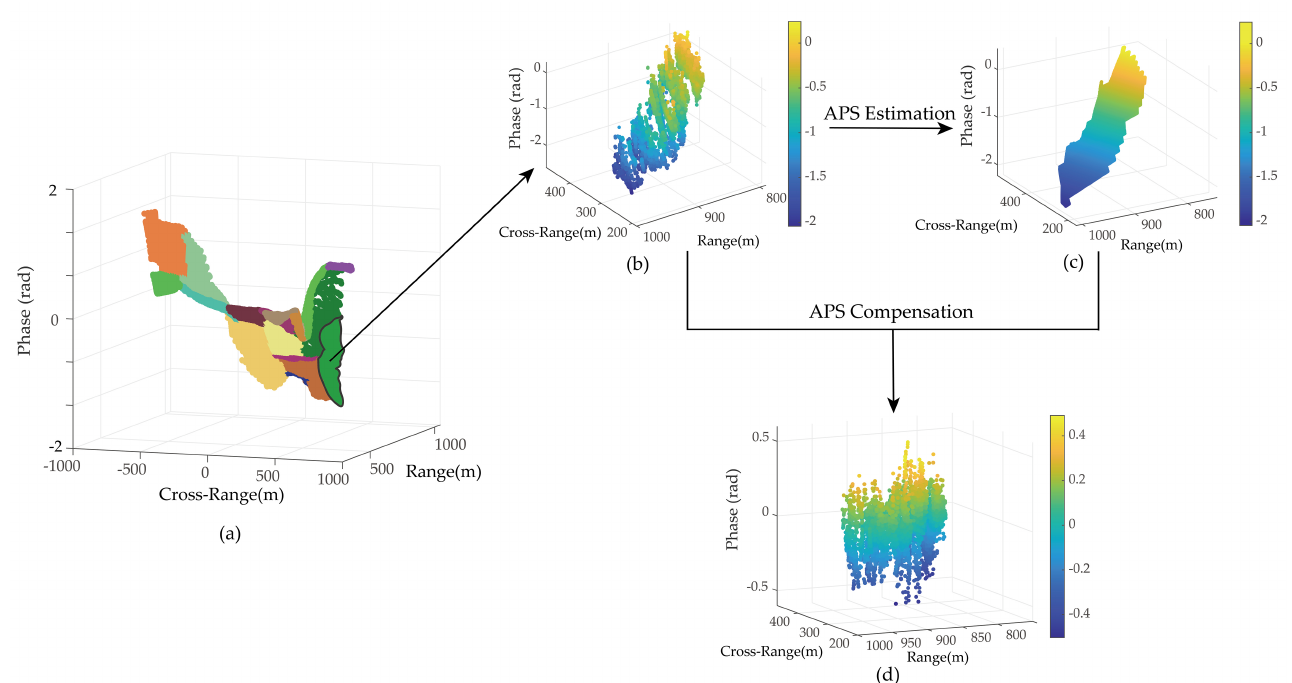
Figure 10. Schematic diagram of atmospheric phase screen (APS) estimation and correction: ( a ) APS partition results, different colors represent different sub-blocks; ( b ) a sub-block of APS; ( c ) APS estimation result of the sub-block in ( b ); ( d ) corrected result of the sub-block in ( b ). The AP of each sub-block is estimated by the regression model shown in Equation